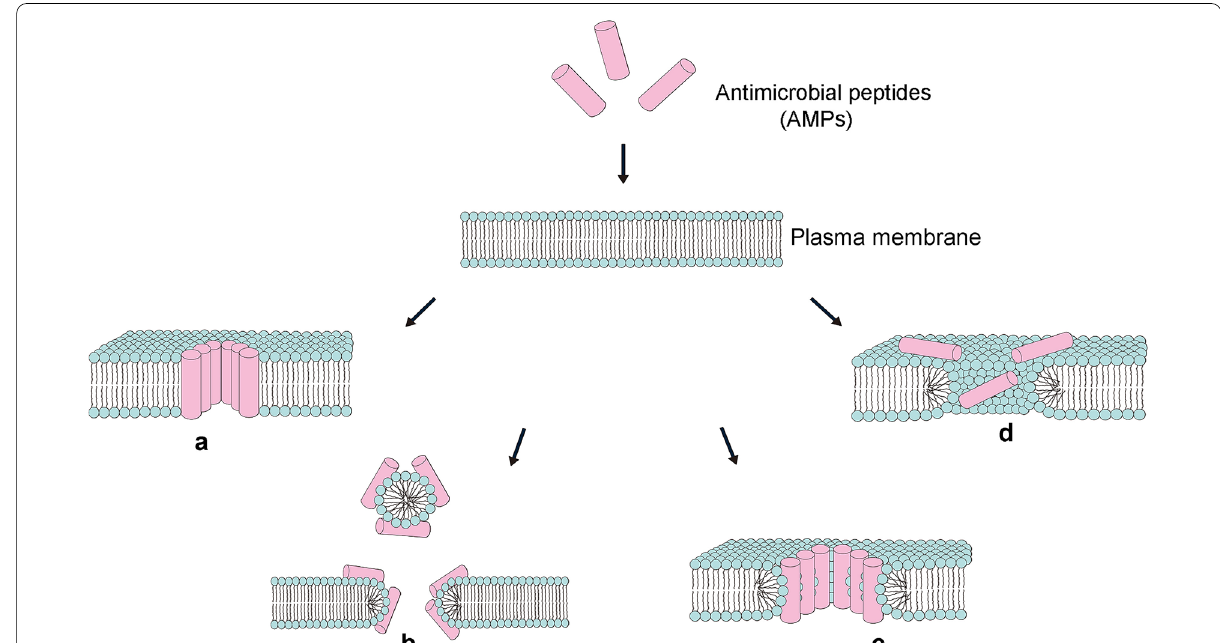
Fig. 3 The four major mechanisms of AMP activity. When the contact between AMPs and the bacterial plasma membranes reaches a critical level, the following four interactions can occur between the AMPs and the plasma membranes. a barrel-stave pore: AMPs insert vertically in the plasma membrane to form transmembrane pores. b carpet mechanism: Peptides are adsorbed parallel to the lipid bilayer to cover the cell surface, causing membrane rupture. c toroidal pore: an intermediate type between the carpet mechanism and the barrel-stave pore.Peptides and lipids form the pores. d disordered toroidal pore: Pore formation is more random and involves fewer peptides, but additional peptides are required to stabilize the